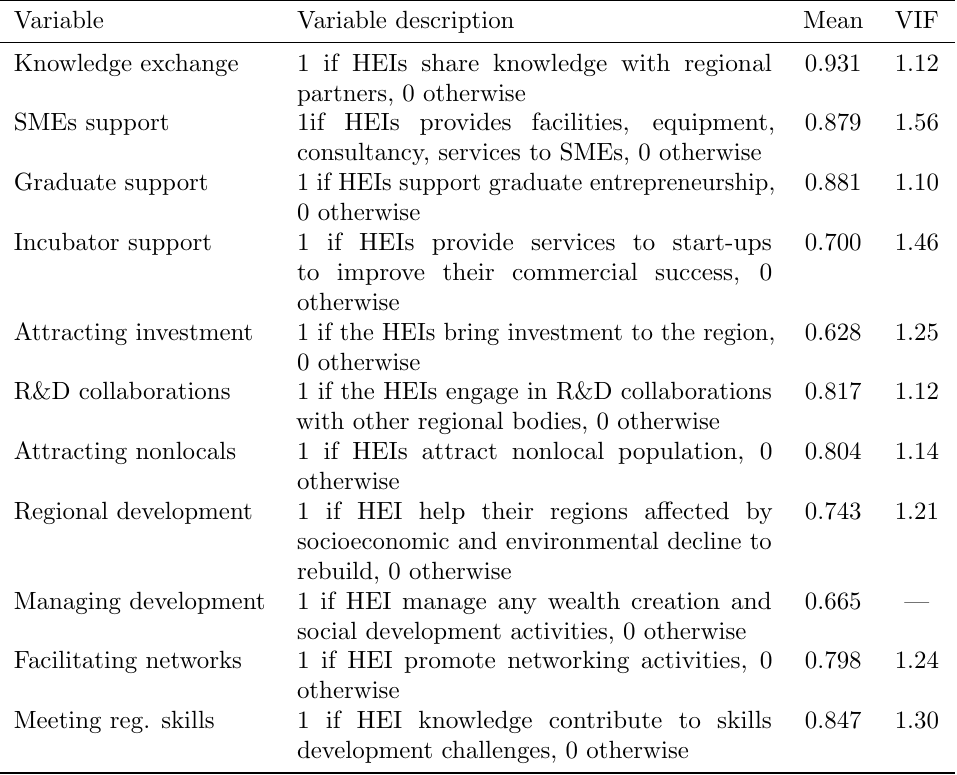
Table 1: Description statistics of the dependent and independent variables